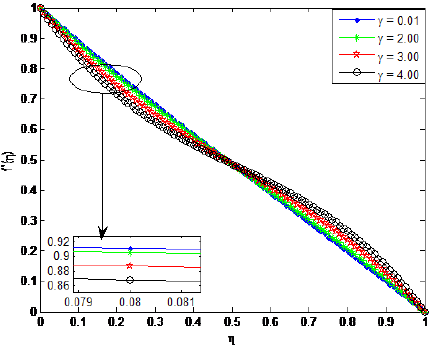
Figure 10. Better insight of the influence of γ on dimensionless velocity profile